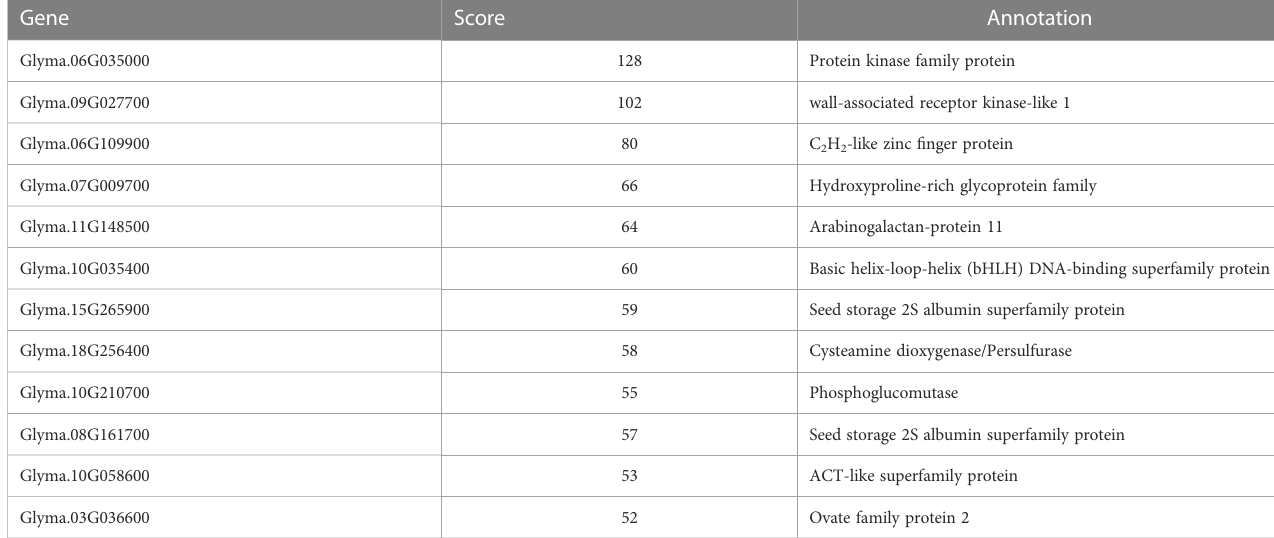
TABLE 1 MCC algorithm